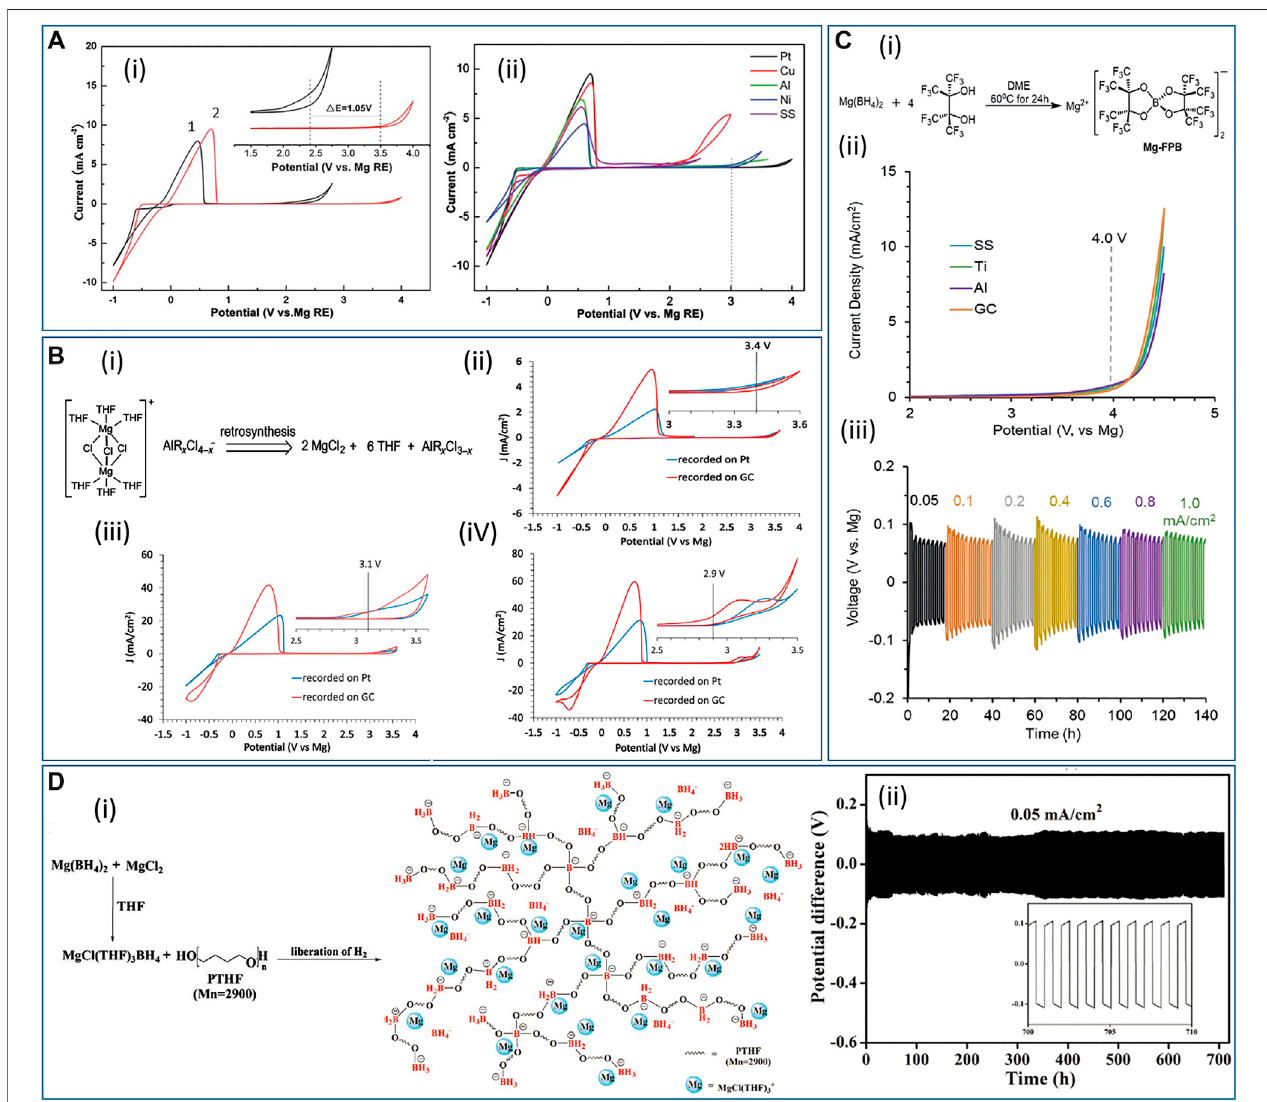
FIGURE 2 | (A-i) Cyclic voltammograms of Pt electrodes at 50 mV s − 1 in (1) 0.4 M Mes 3 B-PhMgCl and 2) 0.5 M Mes 3 B-(PhMgCl) 2 . Inset is an enlargement of the 1.5 – 4 V region. (A-ii) Cyclic voltammograms of Mes 3 B-(PhMgCl) 2 /THF on several working electrodes. Reproduced with permission from (Guo et al., 2012). (B-i) Retrosynthesis ofelectroactive [( μ -Cl) 3 Mg 2 (THF) 6 ] + species. Cyclic voltammograms of (B-ii) MgCl 2 -AlCl 3 /THF, (B-iii) MgCl 2 -AlPh 3 /THF, and (B-iV) MgCl 2 -AlEtCl 2 /THF at 50 mV s − 1 on GC and Pt. All insets show the enlargement of the oxidation region. Reproduced with permission from (Liu et al., 2014). (C-i) Synthesis of